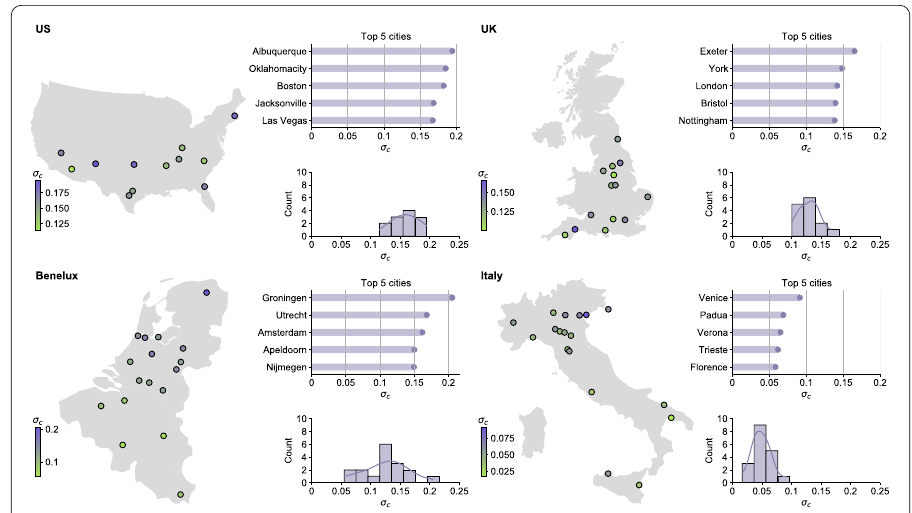
Figure 1 Gender gap in recreational cycling in Strava: overview of cities included in the study. For each of the four geographical areas covered by the study, the figure depicts: the location of cities included in the analysis, the value of the female cycling rate σ c for the five cities displaying the highest σ c and the distribution of σ c in the geographical